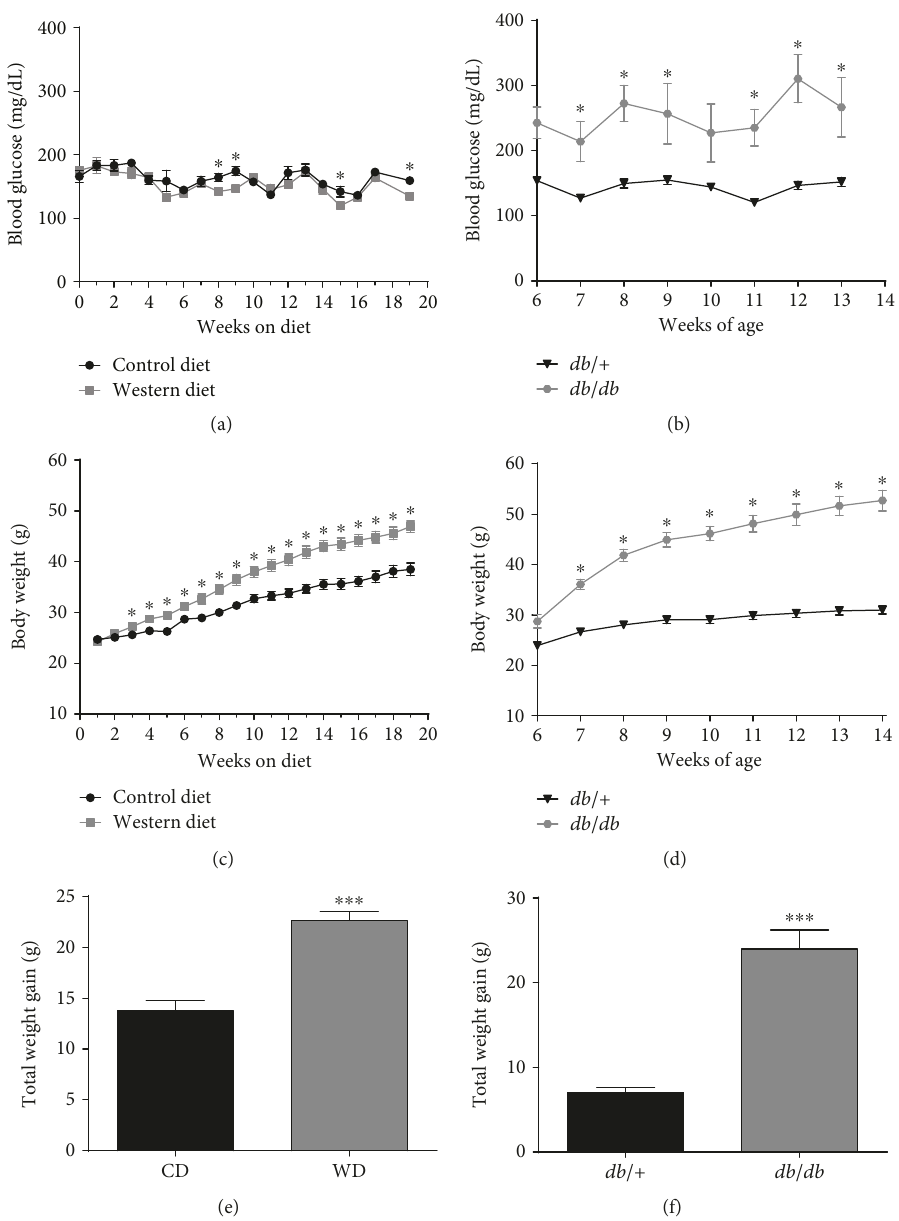
Figure 1: Hyperglycemia develops in genetically driven, but not diet-induced obesity. Blood glucose (a) and body weight (c) in male C57BL/ 6J mice fed either control or Western diet for 20 weeks. Total weight gain (e) at the end of the 20-week feeding period. Blood glucose (b) and body weight (d) in male db /+ and db / db mice between 6 and 14 weeks of age. Total weight gain by 14 weeks of age (f). For body weight measurements (c and d), y- axes are set to the same scale for comparison between study groups. n = 8 per group; means ± SEM; ∗∗∗ p < 0 001 versus control; ∗ p < 0 05 versus control by repeated measures ANOVA. CD: control diet; WD: Western